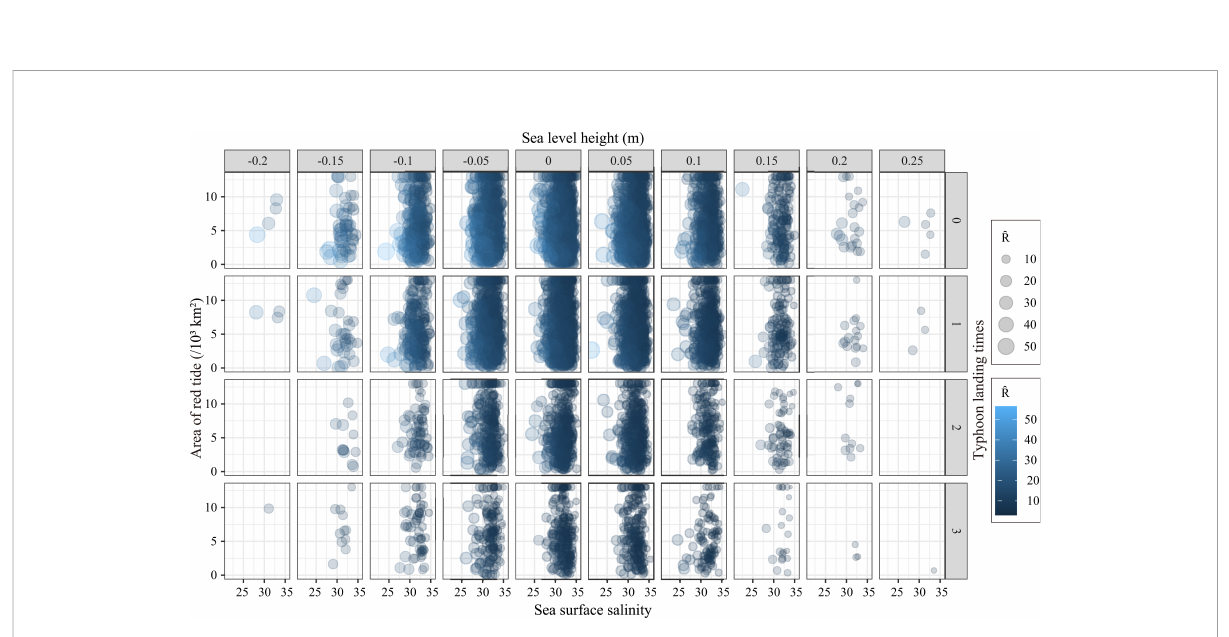
FIGURE 4 Combined effects of environmental factors on the recruitment of Portunus trituberculatus